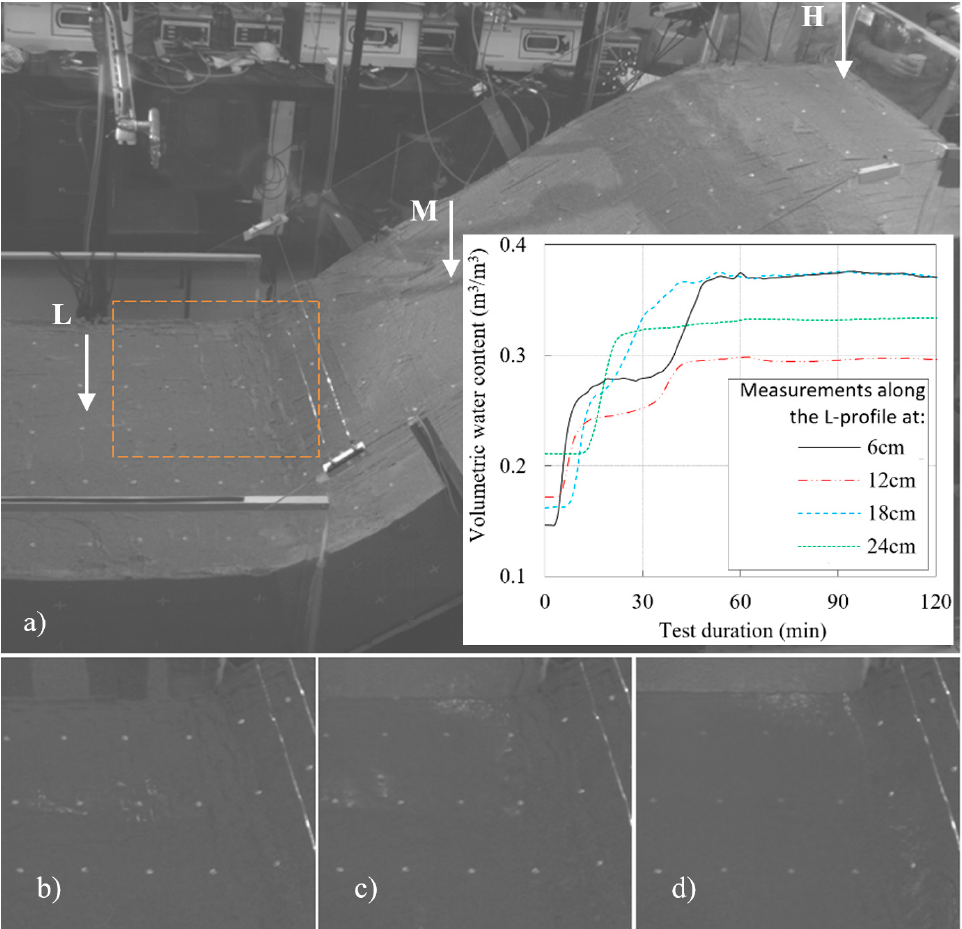
Figure 9. Model from the Example 1 as captured by the system ARAMIS (GOM GmbH): ( a ) at the beginning of the test (with indication of the measurement profiles and VWC changes measured at the L-profile at 6, 12, 18 and 24 cm depth; ( b ) 49th minute of the test with first traces of GWL reaching the surface in the central part of the base; ( c ) 51th minute of the test with the entire base submerged; and ( d ) 56th minute of the test with contours of the first small rotational landslide visible at the foot of the slope.